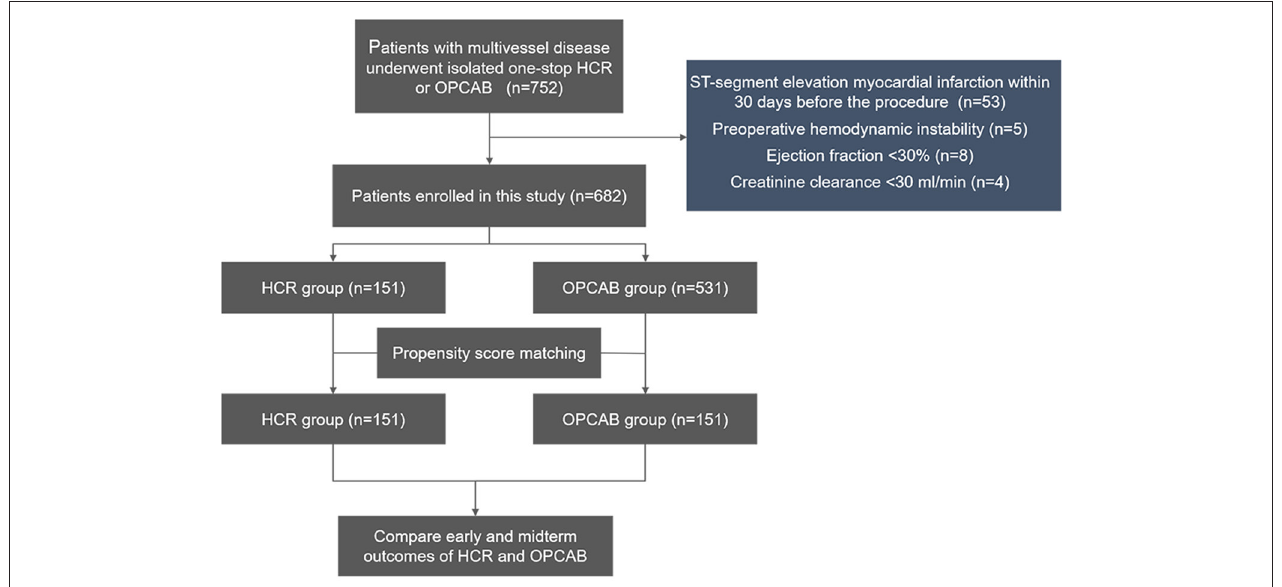
FIGURE 1 | Flow chart of the study. HCR, hybrid coronary revascularization; OPCAB, off-pump coronary artery bypass